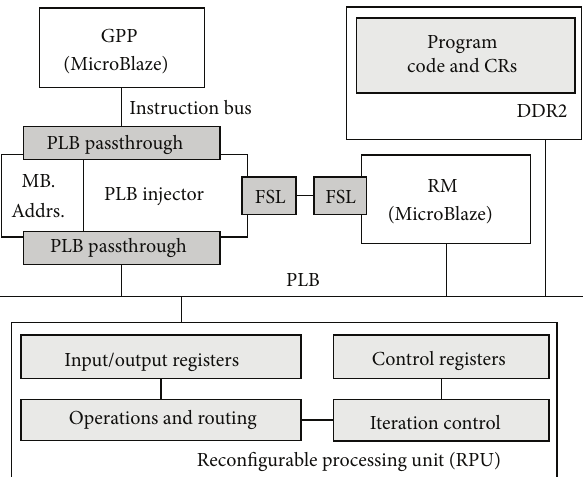
F 5: DDR-PLB architecture (Arch.